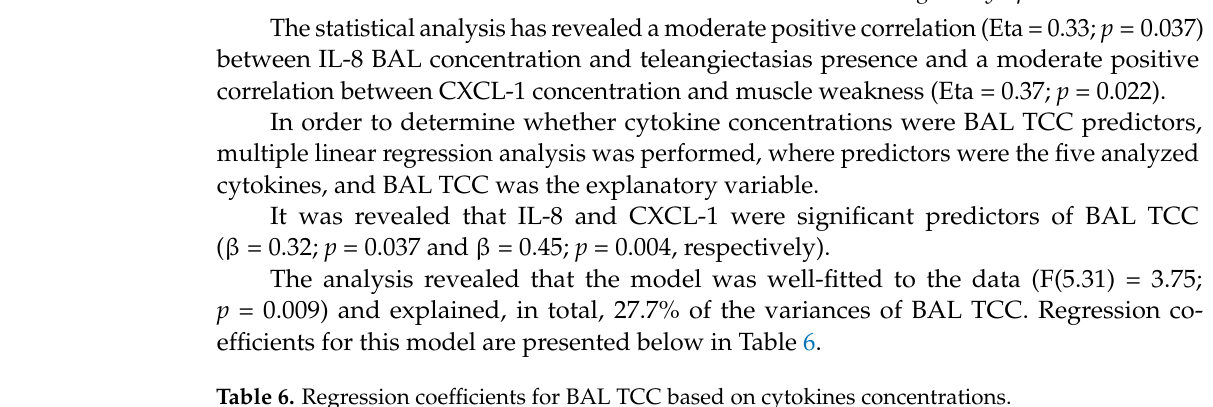
Table 6. Regression coefficients for BAL TCC based on cytokines